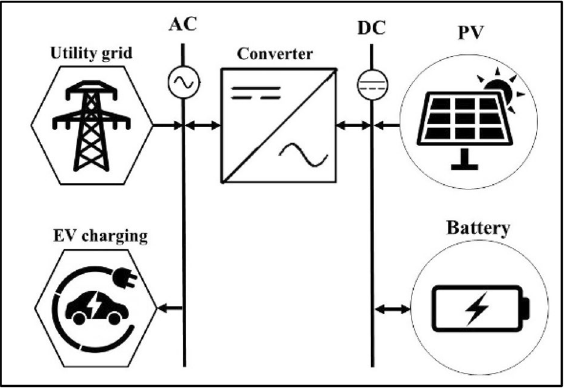
Figure 10. Schematic of a solar-powered EV charging station linked to the